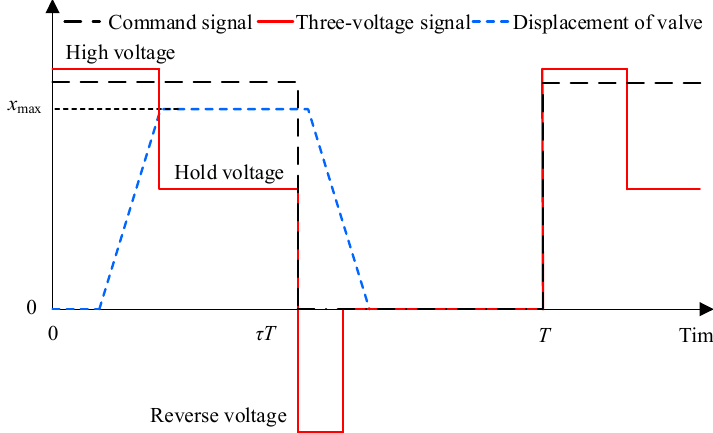
Figure 6. Diagram of three-voltage control signal.